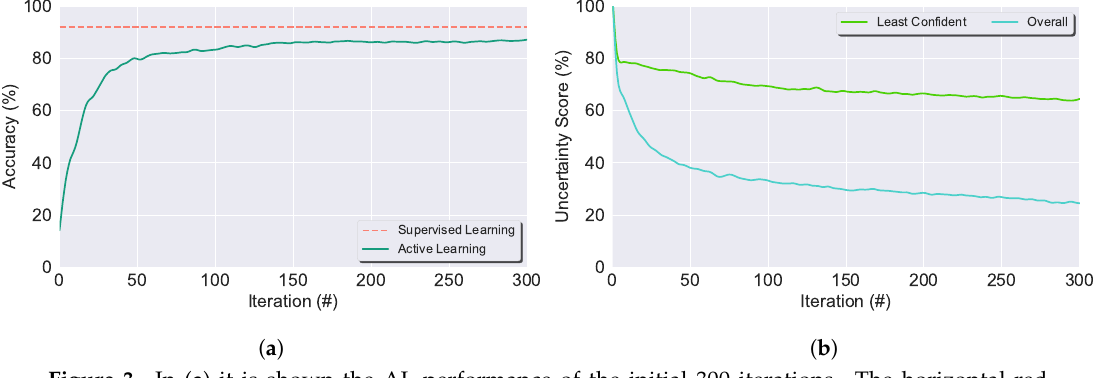
Figure 3. In ( a ) it is shown the AL performance of the initial 300 iterations. The horizontal red line denotes the accuracy average score of Supervised Learning (SL). In ( b ) it is shown the classifier Least Confidence score and Classifier Overall Uncertainty score throughout 300 iterations. ( a ) Least Confidence Uncertainty Score. ( b ) Overall Uncertainty